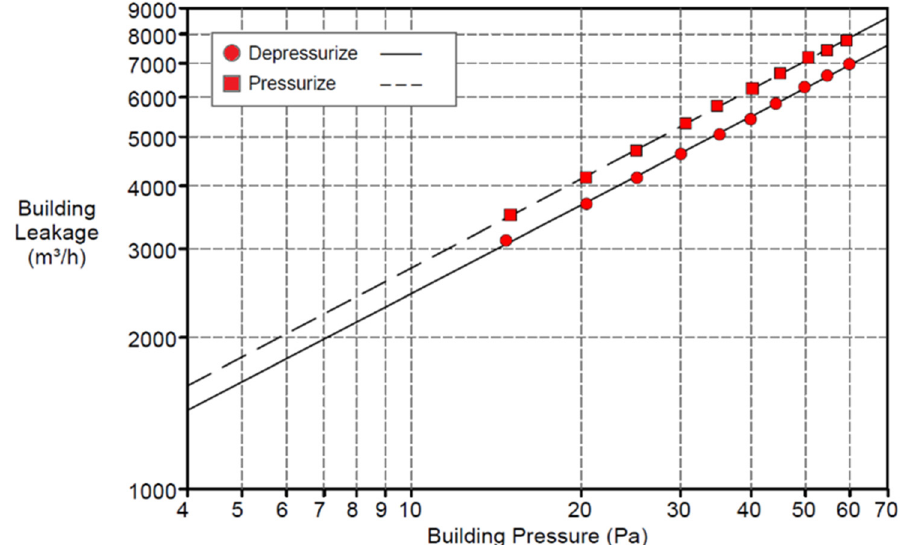
Figure 1. Example air leakage graph using the blower door test.